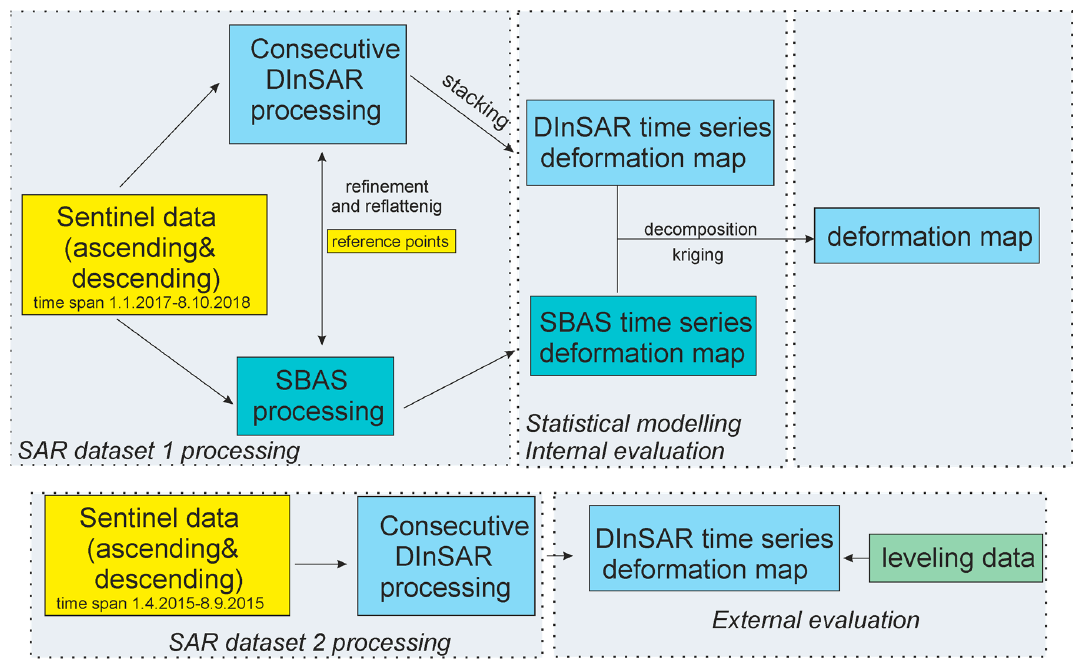
Figure 2. The methodology applied in the presented study.